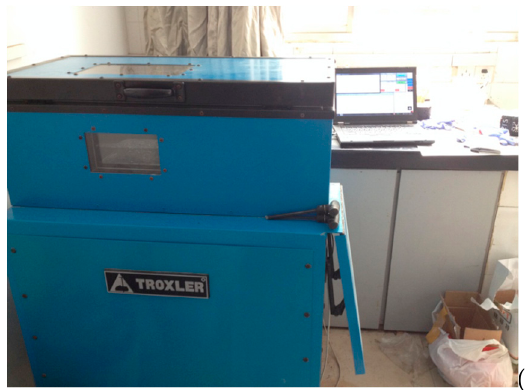
Figure 1. Three fatigue testing apparatuses: ( a ) four-point beam (4PB) fatigue test, ( b ) two-point trapezoidal beam test (Trapezoidal Beam), and ( c ) Overlay Tester.